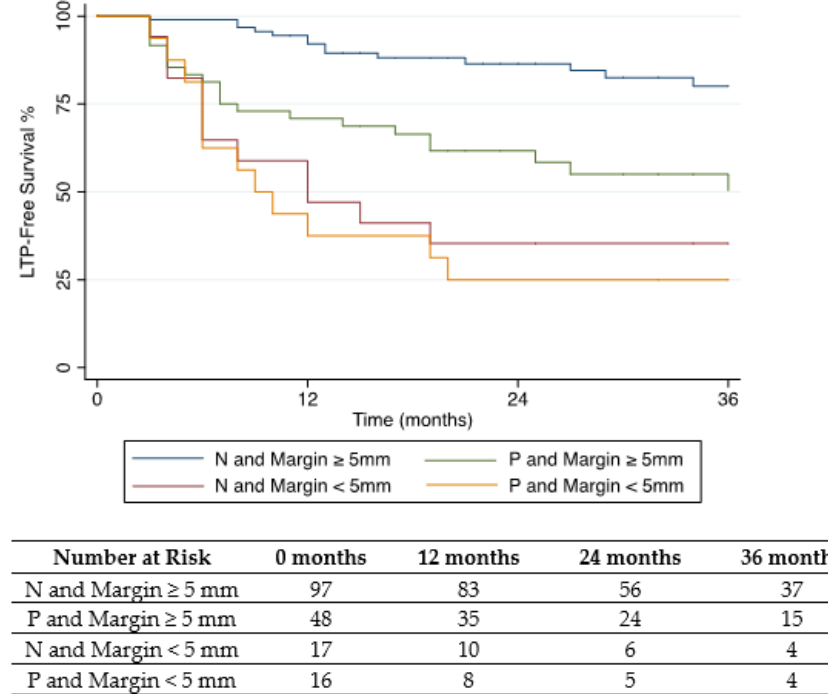
Figure 2. Kaplan–Meier curve of local tumor progression free survival stratified by post-ablation biopsy result (N: Negative or P: Positive) and ablation margin size.